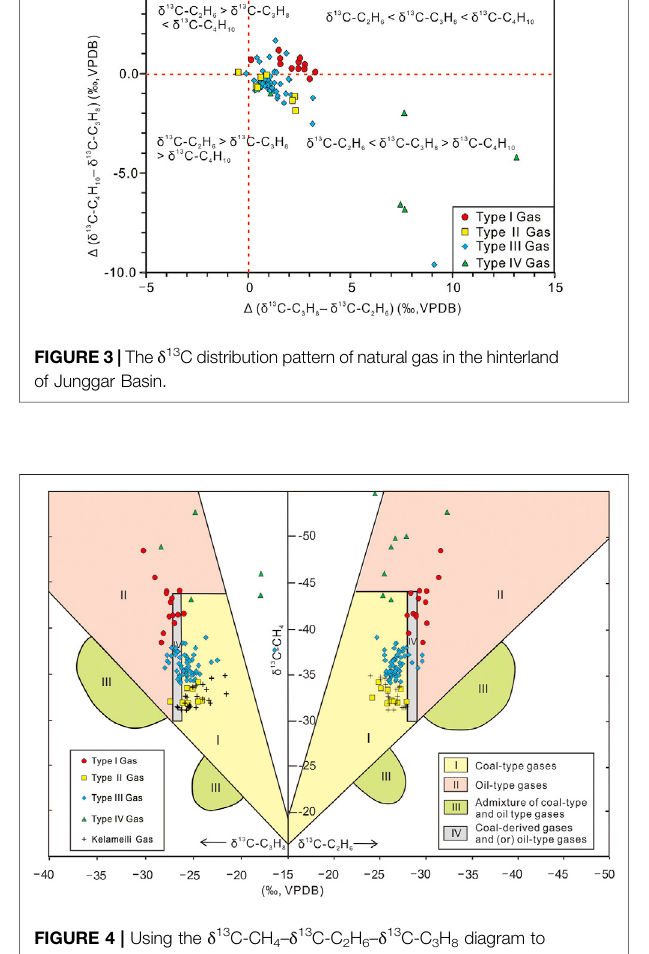
Frontiers in Earth Science |